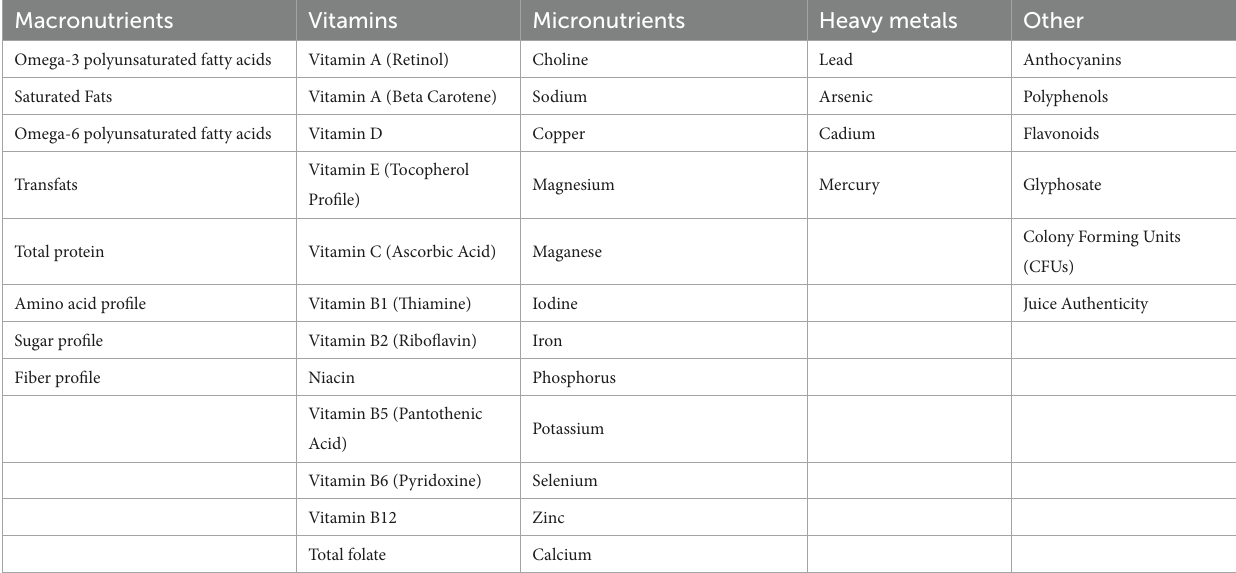
TABLE 3 Product and Ingredient Testing